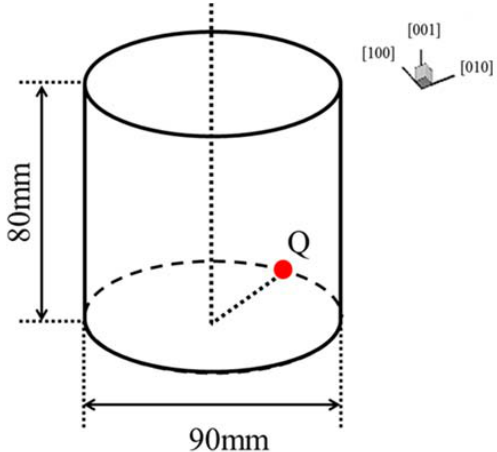
Figure 3. The calculated temperature ( a ) and oxygen ( b ) concentration distributions at the end of the solidification.